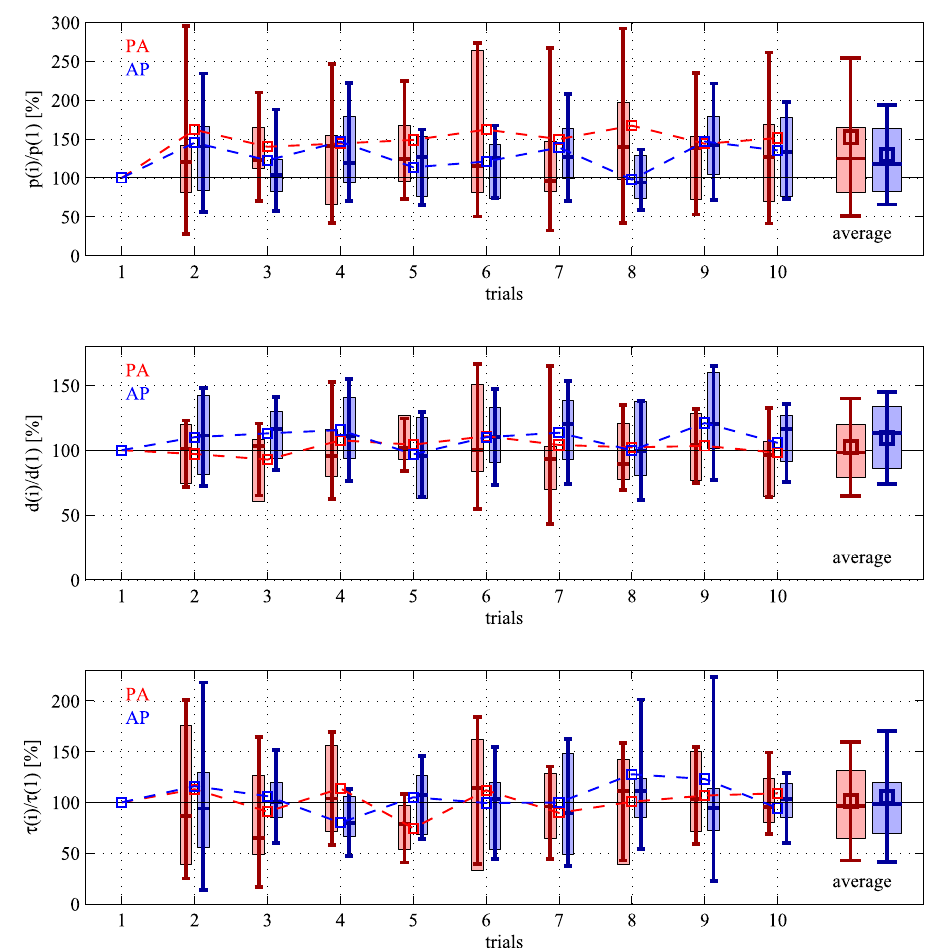
Figure 5. Statistics of the relative variation of the fitted control gains and the reaction delay during the trials compared to the first trial. Square marker and errorbar: mean ± SD for the 10 subjects; boxplot: median and